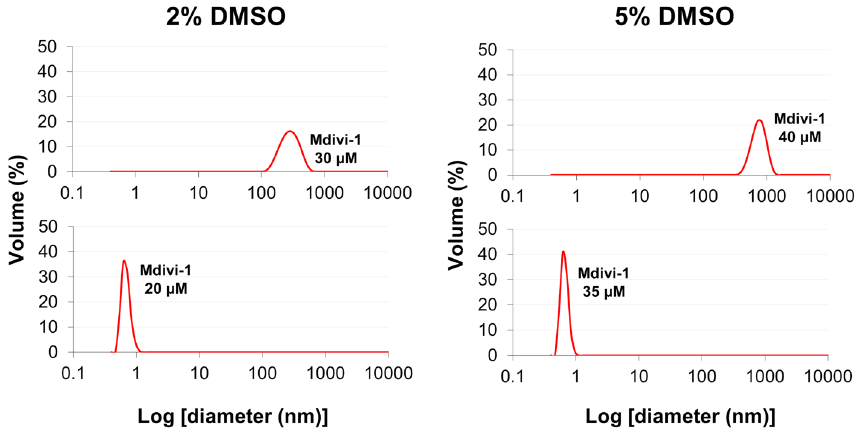
Figure 2. Representative dynamic light scattering for Mdivi-1. The particle size of Mdivi-1 increased from 20 µM to 30 µM in PBS with 2% DMSO (left panel) and from 35 to 40 µM in PBS with 5% DMSO (right panel). This mirrors the experimental conditions in both the SPR and MST